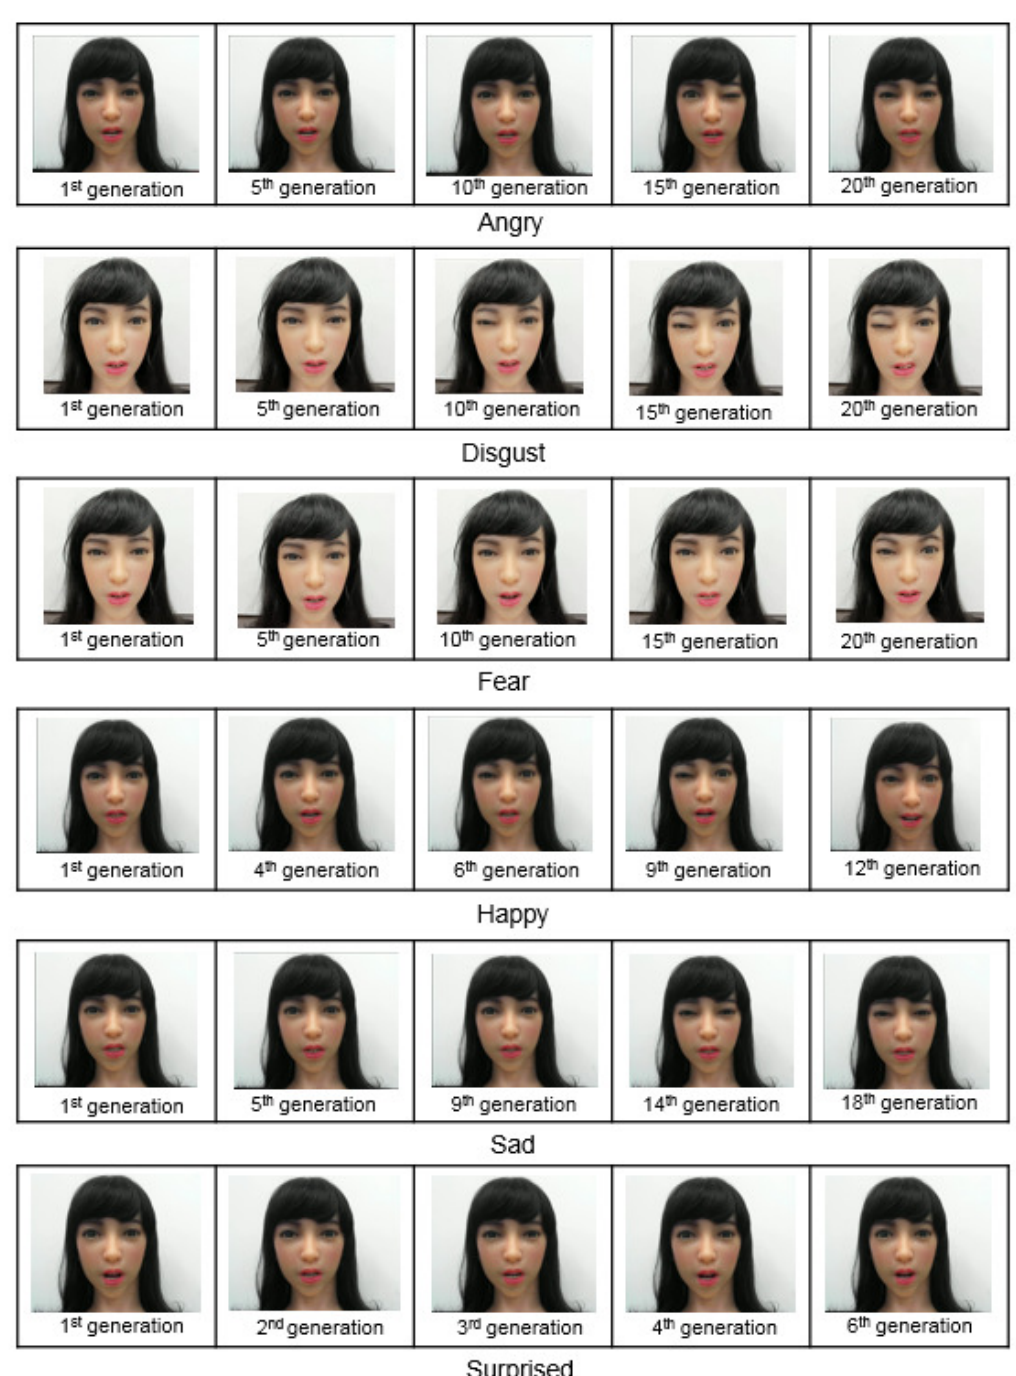
Figure 9. Evolution of different facial expressions in